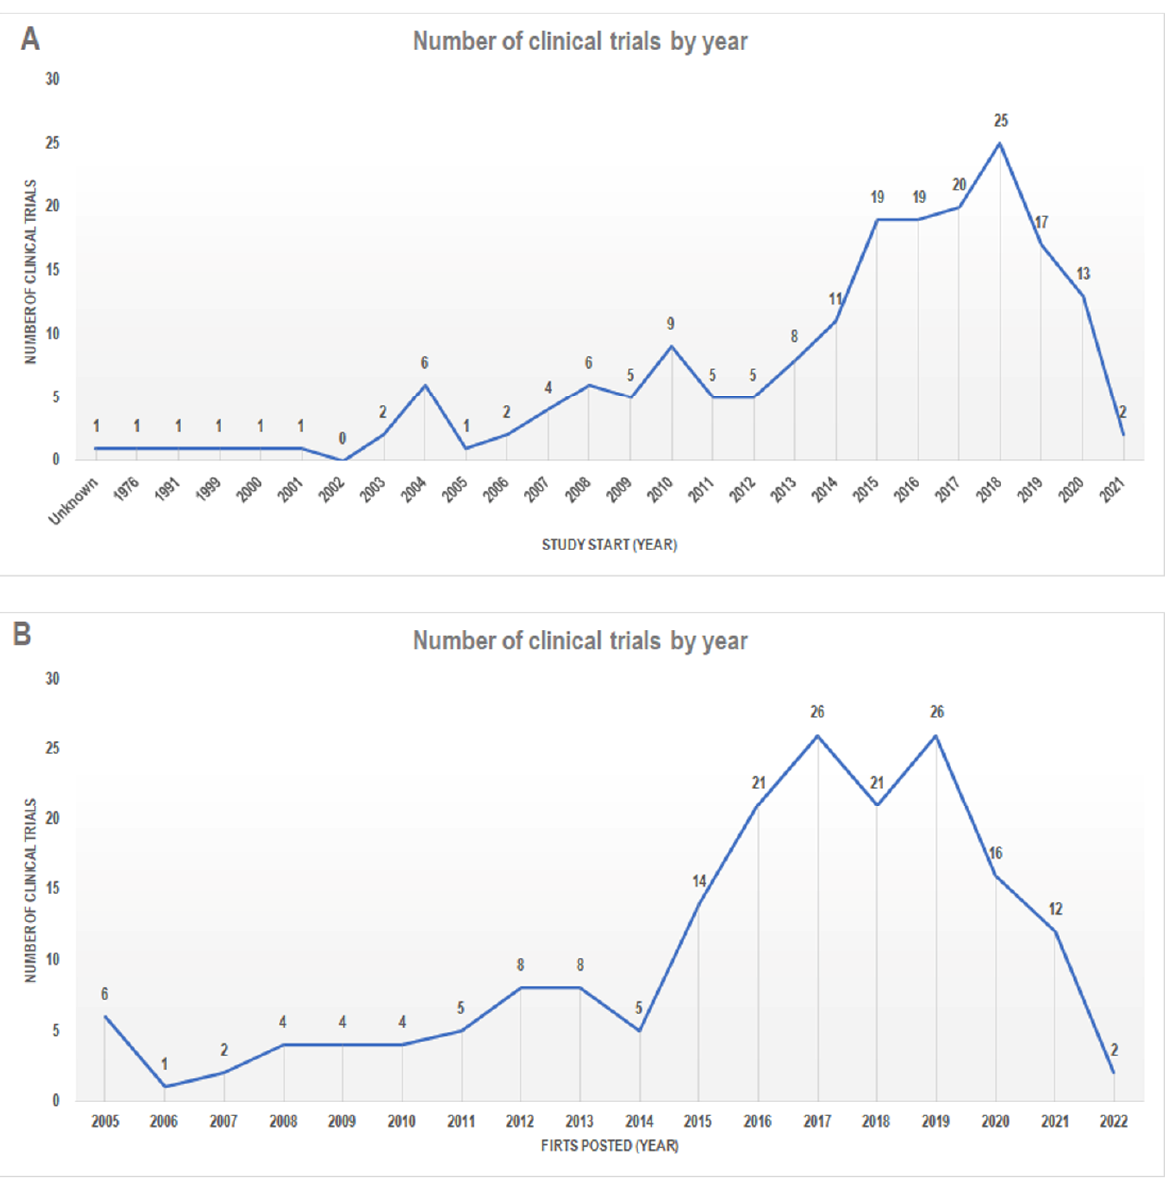
Figure 2. The number of clinical trials classified according to ( A ) “Study Start” and ( B ) “First posted”. Data from http://www.clinicaltrials.gov/ (accessed on 31 January 2022).